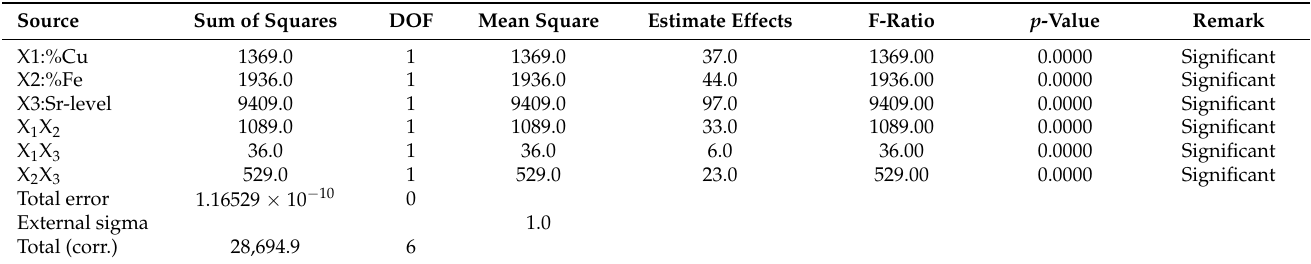
Table 9. Analysis of variance (ANOVA) for cutting force data (Ftm in N).